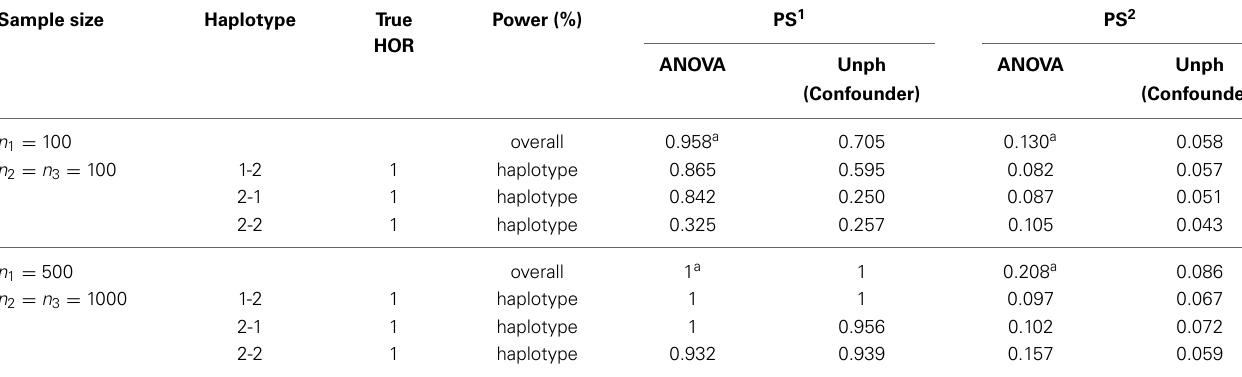
Table 4 | Power of the tests for checking the appropriateness of combining samples in presence of population stratification (PS). Sample size Haplotype True Power (%) PS 1 PS 2 HOR ANOVA Unph ANOVA